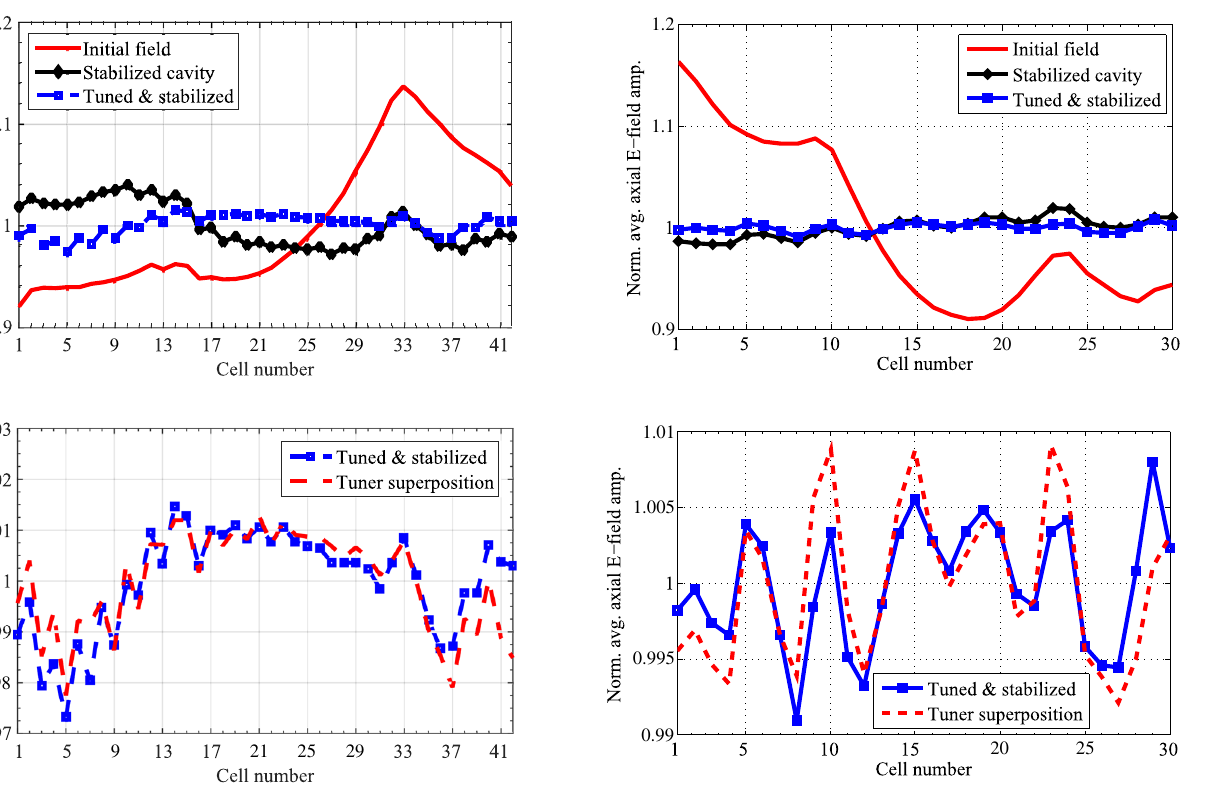
FIG. 13. Top: Field flatness in the Linac4 DTL Tank 2 before stabilization, after stabilization, and after tuning. Bottom: Zoom showing the final field flatness and the prediction from individual tuner